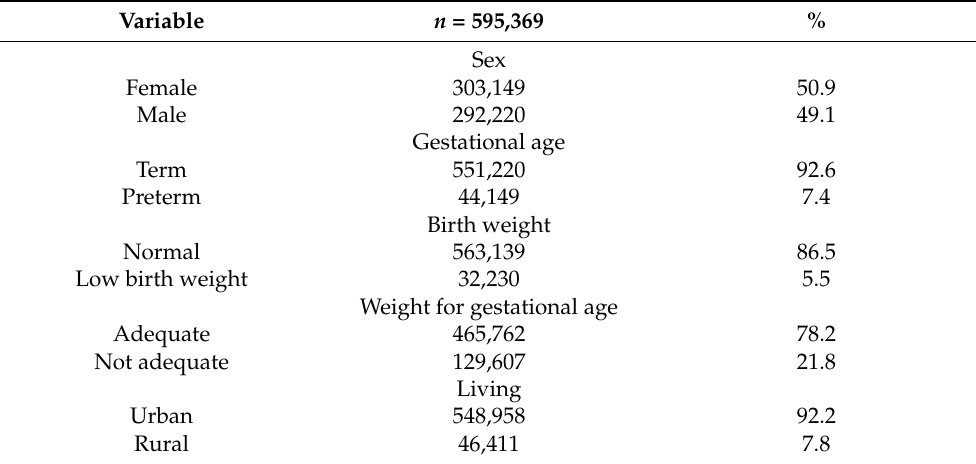
Table 1. Sociodemographic and anthropometric characteristics of Chilean newborns.